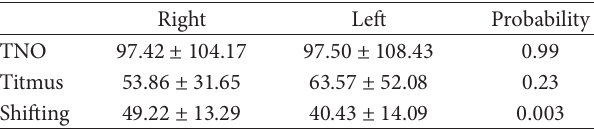
Table 2: Stereopsis scores and shifting amount in Miles test accord- ing to eye dominance. Right Left